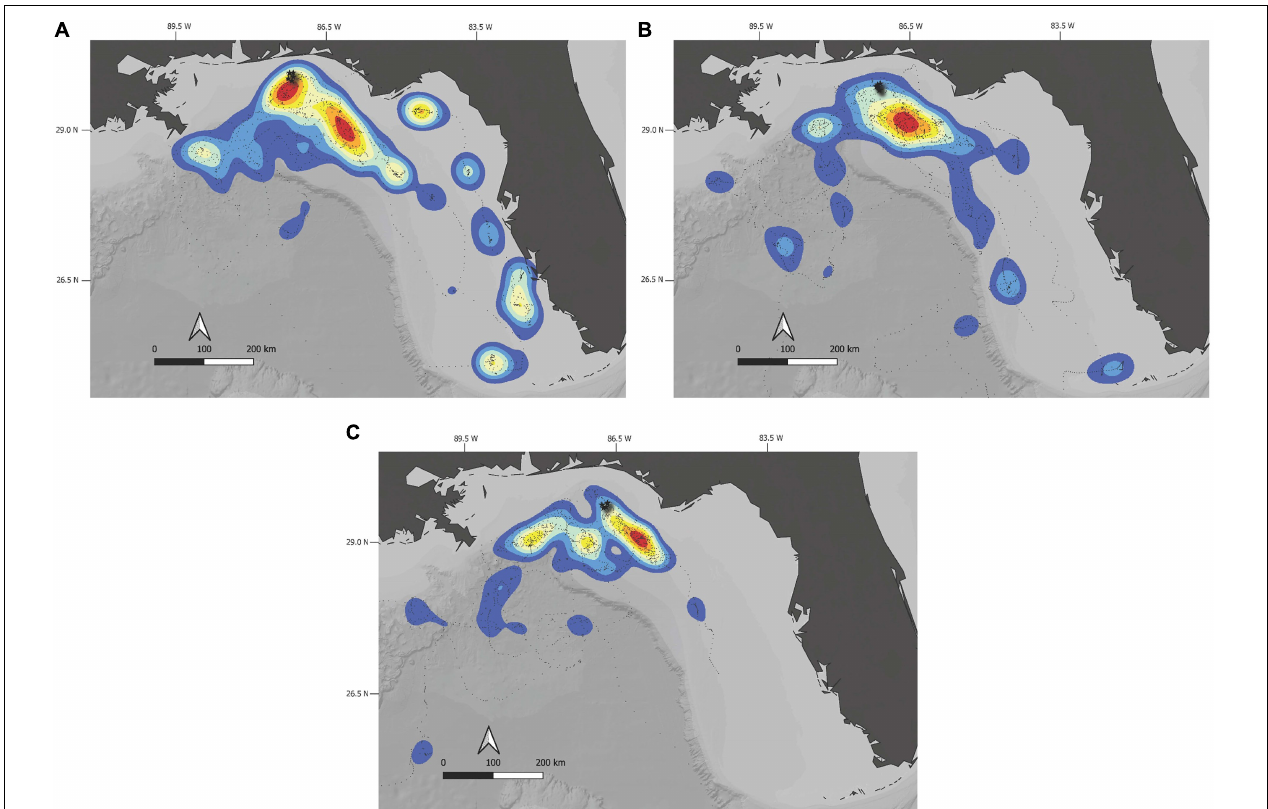
FIGURE 2 | Kernel density maps by year. Colors represent 12.5% increments of the proportion of total density; warmer colors (reds) are greater density and cooler colors (blues) are lower density. The lowest 12.5% of densities are not shown. Initial capture locations are shown with a star, all other estimated locations are shown by black dots. Kernel density radius was 56.419 km. (A) 2015 Kernel Density Map. (B) 2018 Kernel Density Map. (C) 2019 Kernel Density Map.